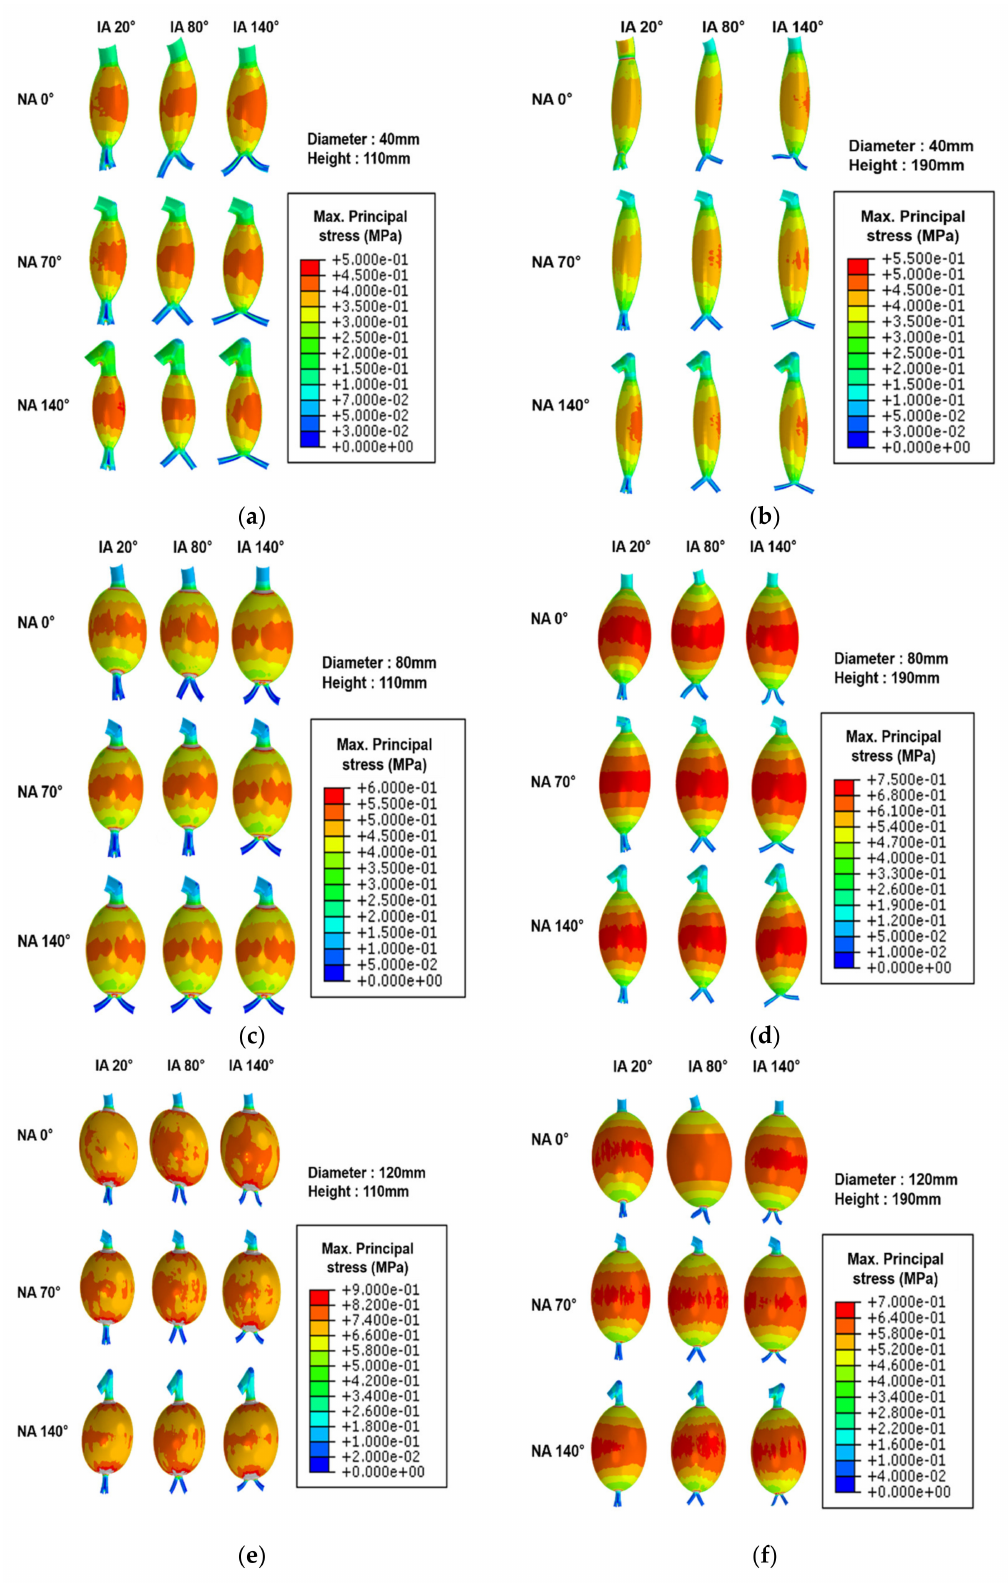
Figure 6. Maximum principal stress contour in inner wall. ( a ) Diameter: 40 mm; height: 110 mm; ( b ) diameter: 40 mm; height: 190 mm; ( c ) diameter: 80 mm; height: 110 mm; ( d ) diameter: 80 mm; height: 190 mm; ( e ) diameter: 120 mm; height: 110 mm; and ( f ) diameter: 120 mm; height: 190